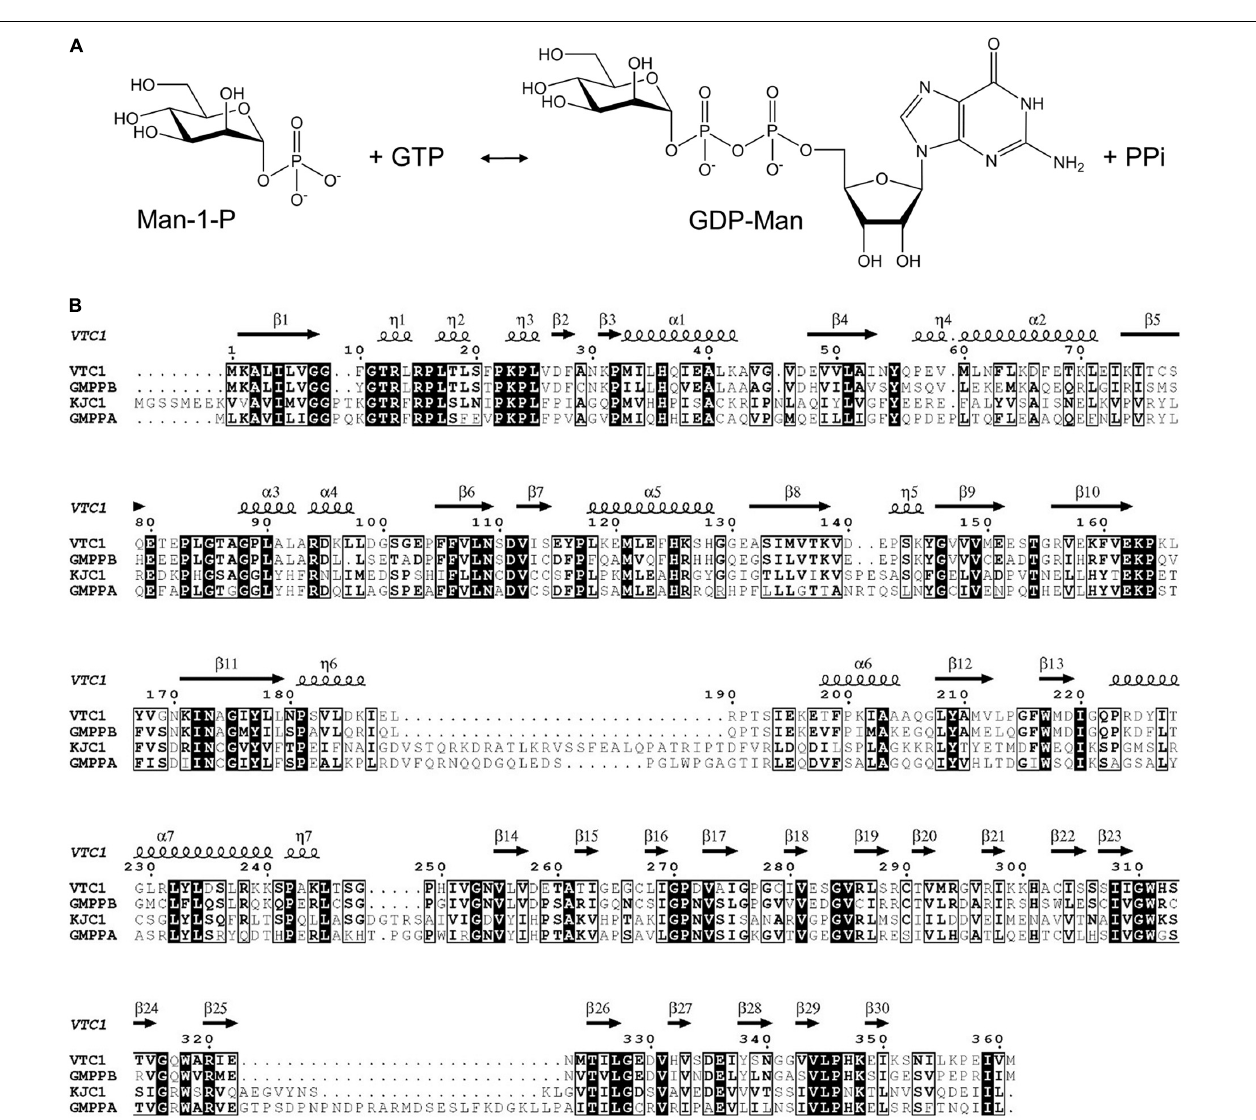
FIGURE 1 | GMPase-catalyzed reaction and amino acid sequences of VTC1, GMPPB, KJC1, and GMPPA. (A) Interconversion of Man-1-P and GDP-Man. (B) Sequence alignment of VTC1, GMPPB, KJC1, and GMPPA. Conserved residues are in black background and similar residues are boxed. The secondary structural elements of VTC1 defined by DSSP are shown on the